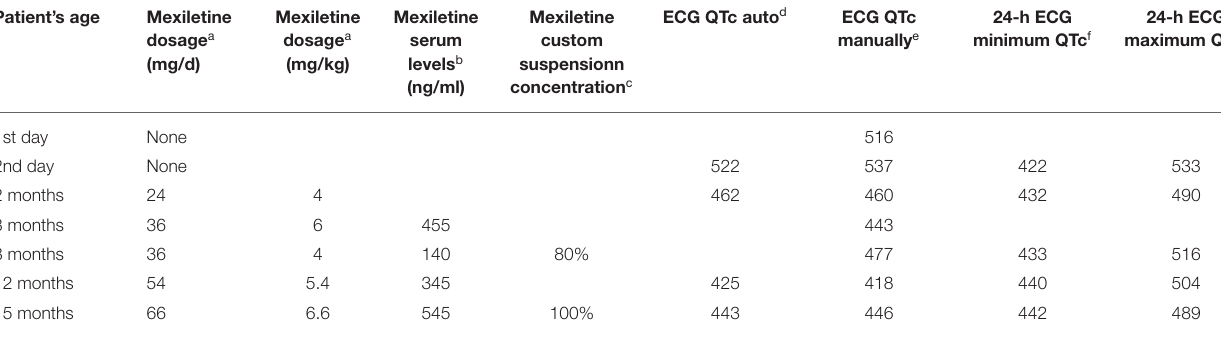
TABLE 1 | Mexiletine dosage, serum levels, and QTc values. Patient’s